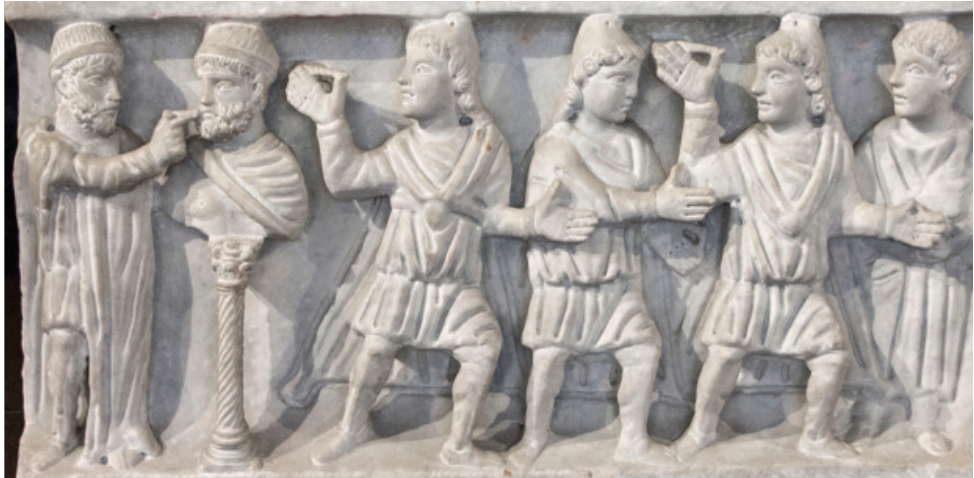
Figure 1. Syracuse (Italy). Museo Archeologico Regionale Paolo Orsi. Adelphia Sarcophagus (detail). Nebuchadnezzar and the three young Jewish men. Photo: Davide Mauro, Wikimedia Commons (CC BY-SA 4.0).